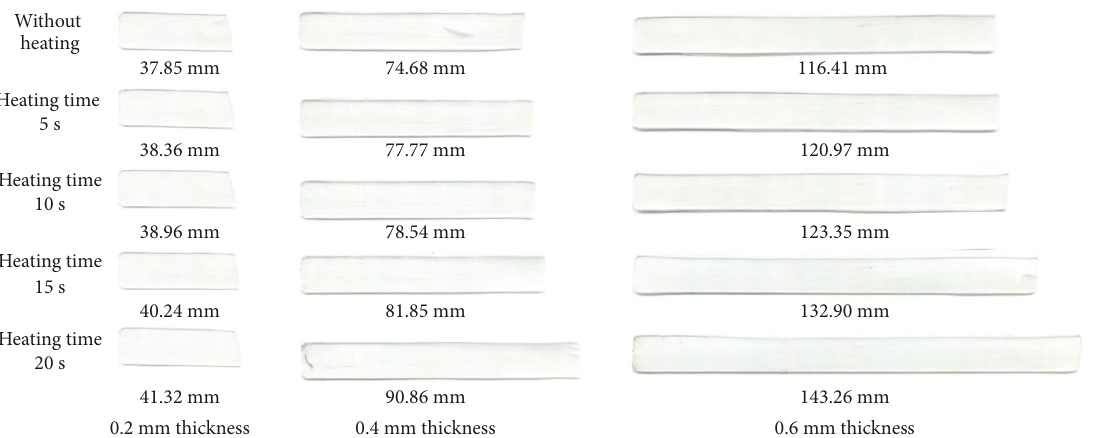
Figure 15: Experimental results for melt flow length with the polypropylene material at different heating times.